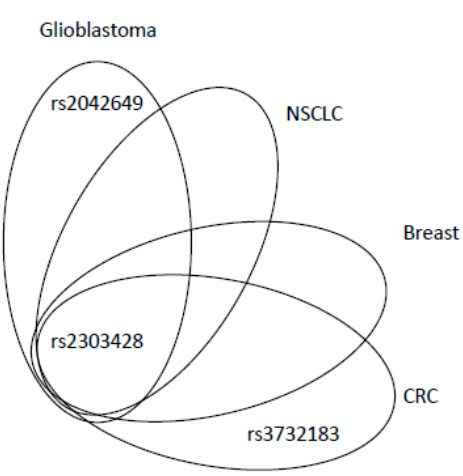
Figure 5. Venn diagram showing relevant MSH2 SNPs associated with adverse effects, in overlap among different cancer types or peculiar for specific malignancies. CRC: colorectal cancer; NSCLC: non-small-cell lung cancer.